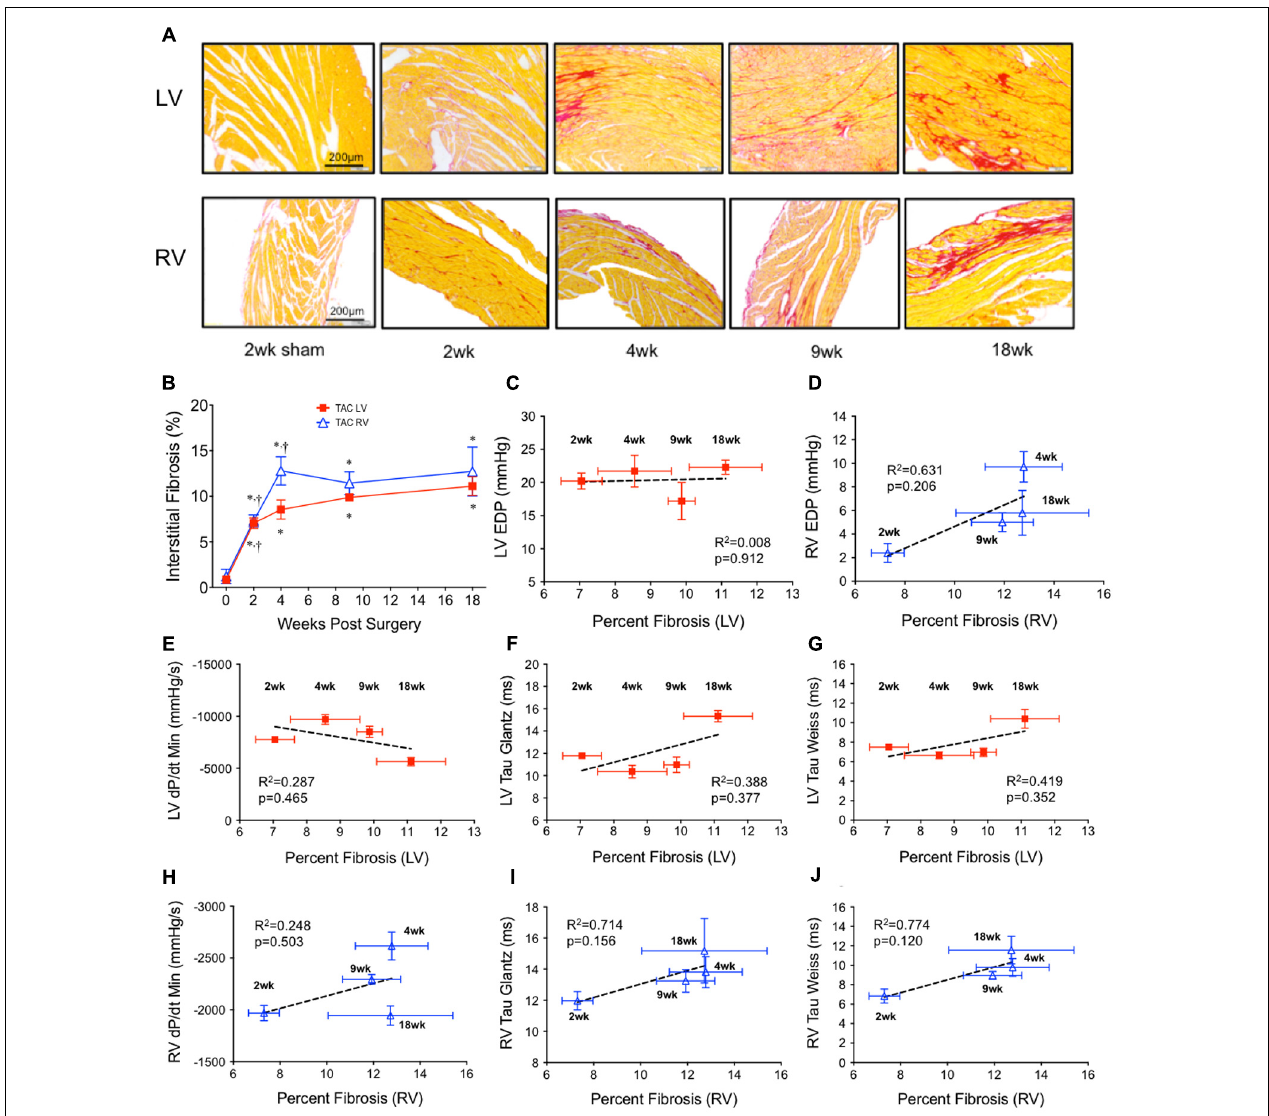
FIGURE 2 | Ventricular interstitial fibrosis in both ventricles over 18 weeks of TAC. (A) Representative images stained with Picrosirius Red (top panel; left ventricle; LV, bottom panel; right ventricle; RV). (B) Average interstitial fibrosis over time in both ventricles ( n = 6 for each point). Sham was unchanged over 18 weeks and was represented by the point at x = 0. ∗ p < 0.05 vs. age-matched sham. † p < 0.05 vs. previous time point. Linear regression was run on correlations between average fibrosis and all invasive indicies of diastolic function: (C) LV end diastolic pressure (LV EDP), (D) RV end diastolic pressure (RV EDP), (E) LV dP/dt min , (F) LV Tau Glantz, (G) LV Tau Weiss, (H) RV dP/dt min , (I) RV Tau Glantz, (J) RV Tau